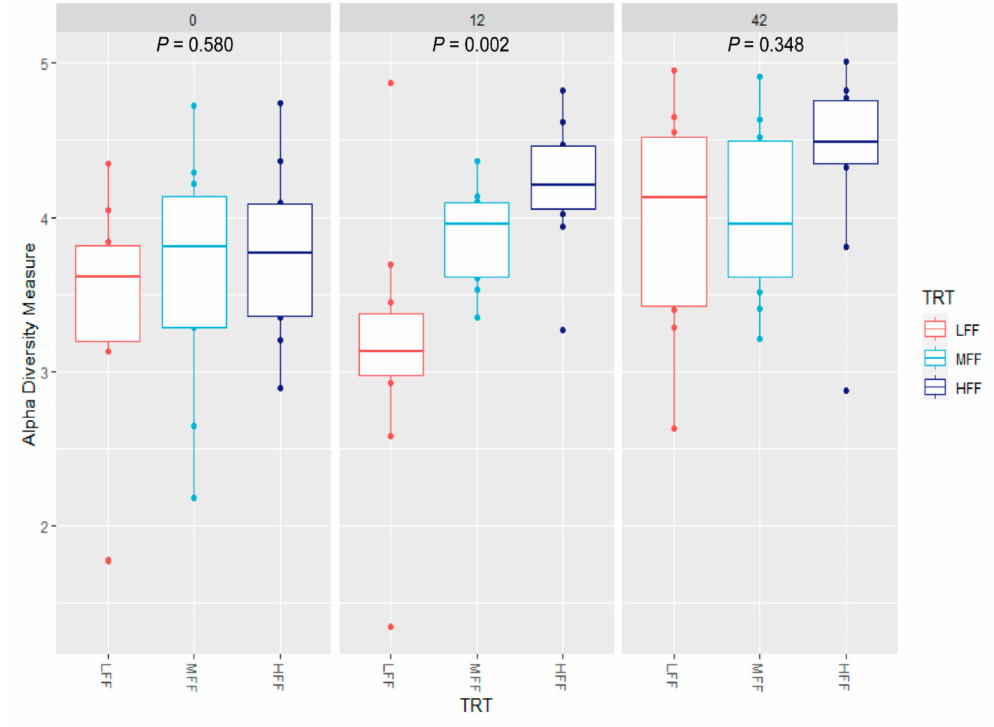
Figure 3. Shannon diversity boxplots of fecal microbial populations in pigs inoculated with Brachyspira hyodysenteriae and fed a lowly fermentable diet (LFF), an intermediate fermentability diet (MFF), and a highly fermentable diet (HFF) at days post inoculation 0, 12, or 42. TRT = treatment.